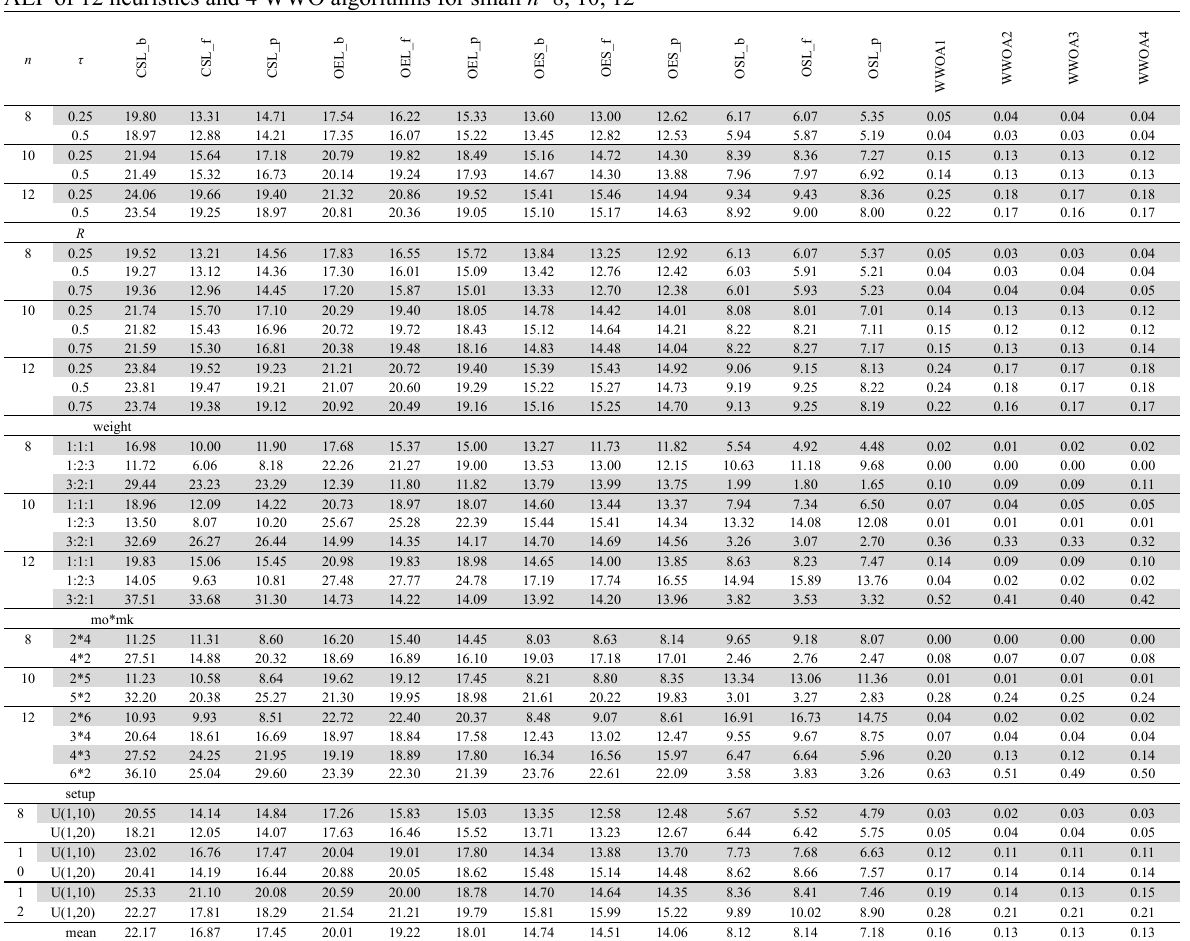
AEP of 12 heuristics and 4 WWO algorithms for small n =8, 10,